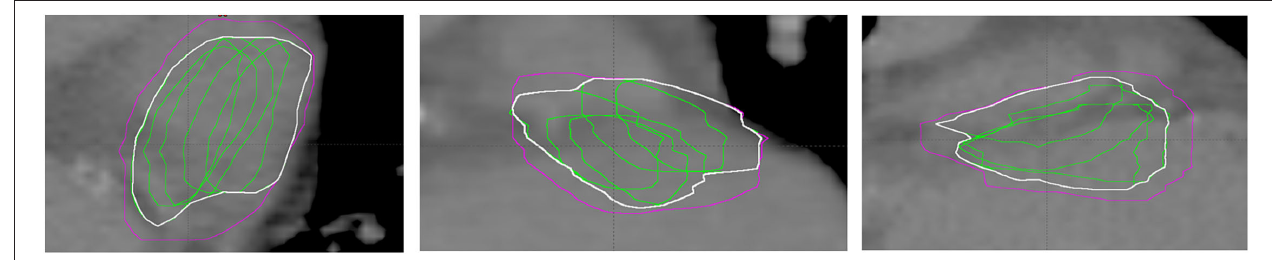
FIGURE 2 | Example of ITV GDM based on maximum detected translation (magenta) vs. ITV GDM − SUM (white) based on merging motion sampling subvolumes (green). From left to right: transverse, coronal, and sagittal